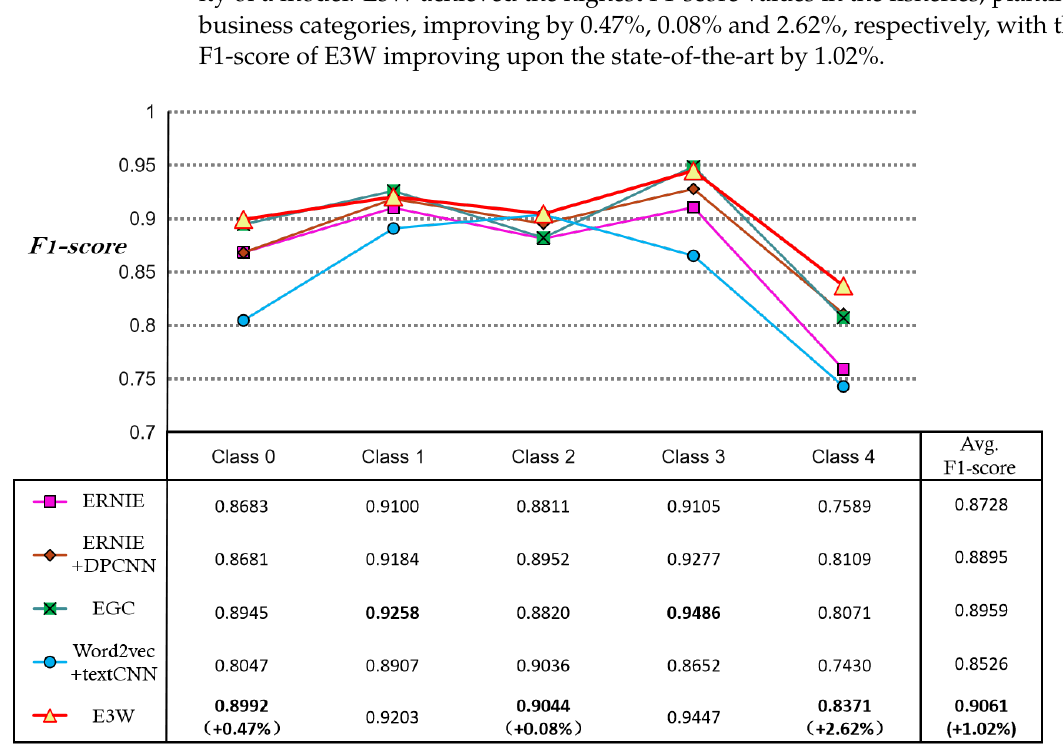
Figure 16. Comparison of F1-scores for E3W and the four sub-models, with the best experimental results in bold and the number in brackets representing the comparison of the current model with the previous best model.